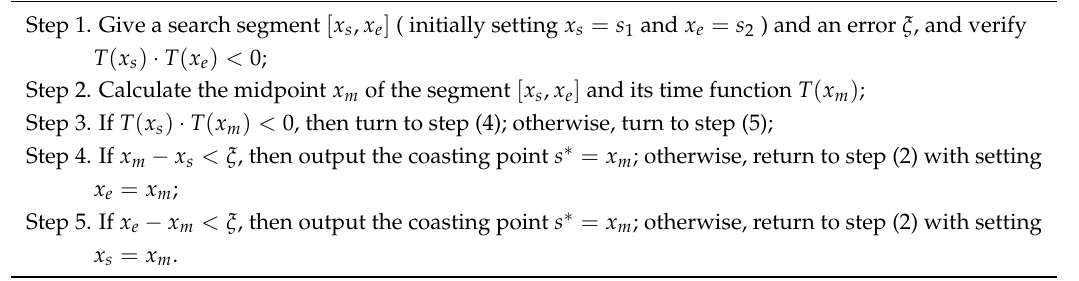
Algorithm 1: The dichotomization algorithm for calculating the optimal coasting